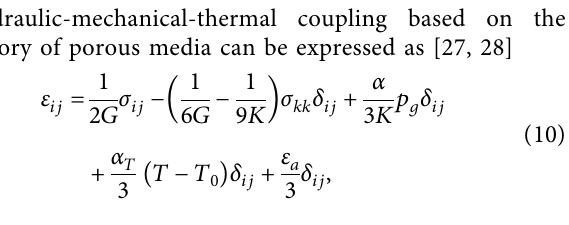
Figure 5: Variation of coalbed methane pressure with different initial coalbed permeability. (a) k (c) k 0 � 13 × 10 − 17 m 2 . (d) k 0 � 17 × 10 − 17 m 2